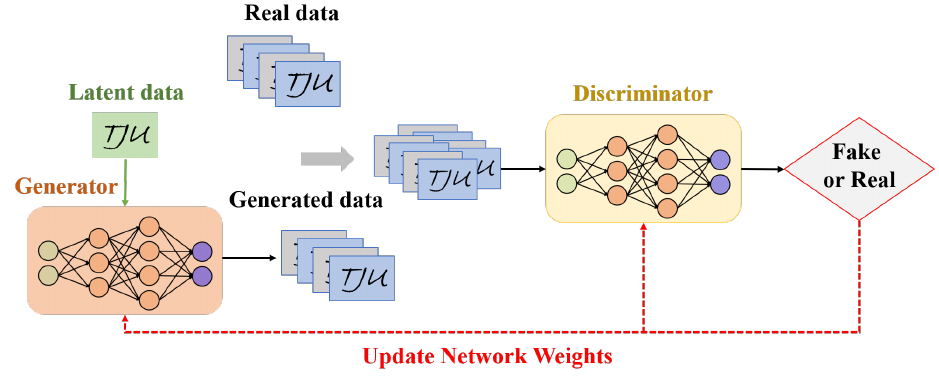
Figure 9. Example of GAN